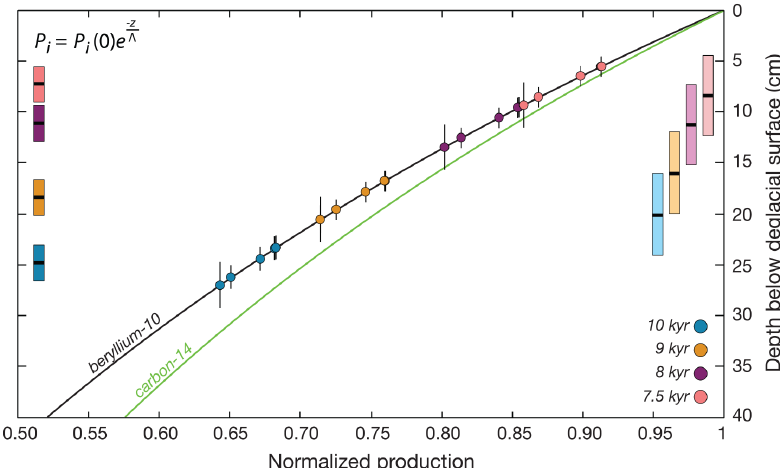
Figure 15. Modeled 10 Be (black line) and in situ 14 C (green line) production with depth in bedrock using a typical rock density of 2.65gcm − 3 for gneiss. A normalized 10 Be and in situ 14 C concentration of 1 equals a prescribed exposure duration of 10, 9, 8, or 7.5kyr. Symbols mark the depth below the prescribed deglacial surface along the production–depth profile that the GrIS would have to erode to during the period of historical ice cover that results in our measured nuclide concentrations. The 10 Be production–depth profile is not fit to the data points and any 10 Be measurement will fall somewhere along the depth profile. Bars on the left ( 10 Be) and right ( 14 C) sides of the diagram are the average erosional depths ( ± 1SD) of each exposure–erosion scenario (see Table S9). For figure clarity, we only show where our individual 10 Be measurements fall along the production–depth profile; the average erosional depths based on the in situ 14 C measure- ments are on the right side of the figure (Table S9). Production by spallation and muons are calculated independently (muons according to Balco, 2017; model 1A). Z is the mass depth below the surface (gcm − 2 ) and is the product of depth (cm) and material density (gcm − 3 ). P i is the production rate of 10 Be and in situ 14 C (atomsg − 1 yr − 1 ) by spallation or muons at depth z . P i (0) is the surface production rate via spallation or muons. (cid:51) is the effective attenuation length (gcm − 2 ). Included here are only 10 Be and in situ 14 C concentrations for